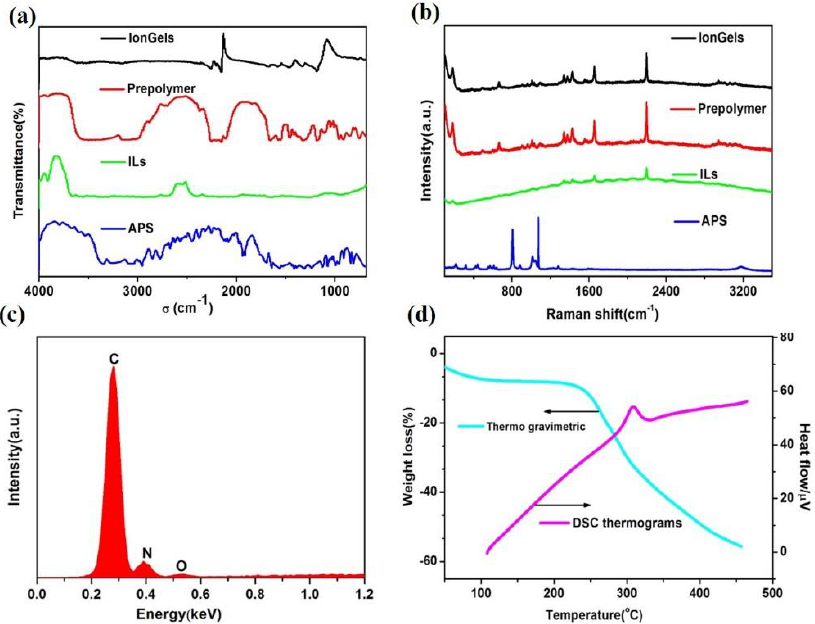
Figure 2. ( a ) Fourier transform infrared spectra. ( b ) Raman spectra. ( c ) Energy Dispersive X-ray spectrum. ( d ) Thermo gravimetric and Differential scanning calorimetry thermo-gram curves of the ionogels. 119